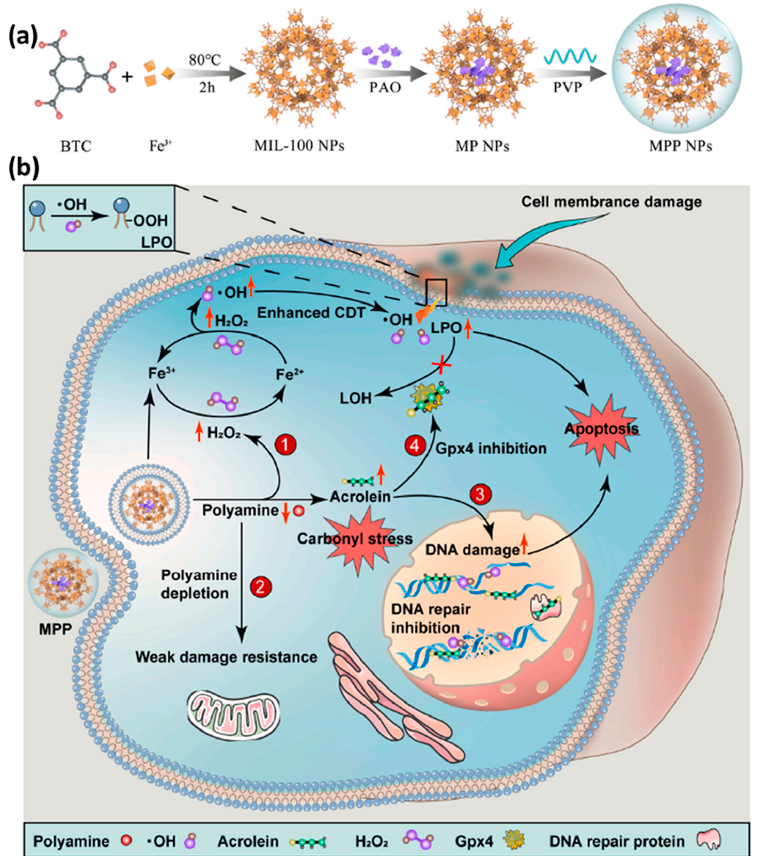
Figure 13. ( a ) Schematic illustration for the synthesis process of Fe–MIL–100@PAO@PVP (MPP). ( b ) Schematic illustration of the utility of MPP nanoplatform for cancer therapy. Reproduced from Ref. [148] with permission from Elsevier, copyright 2021.